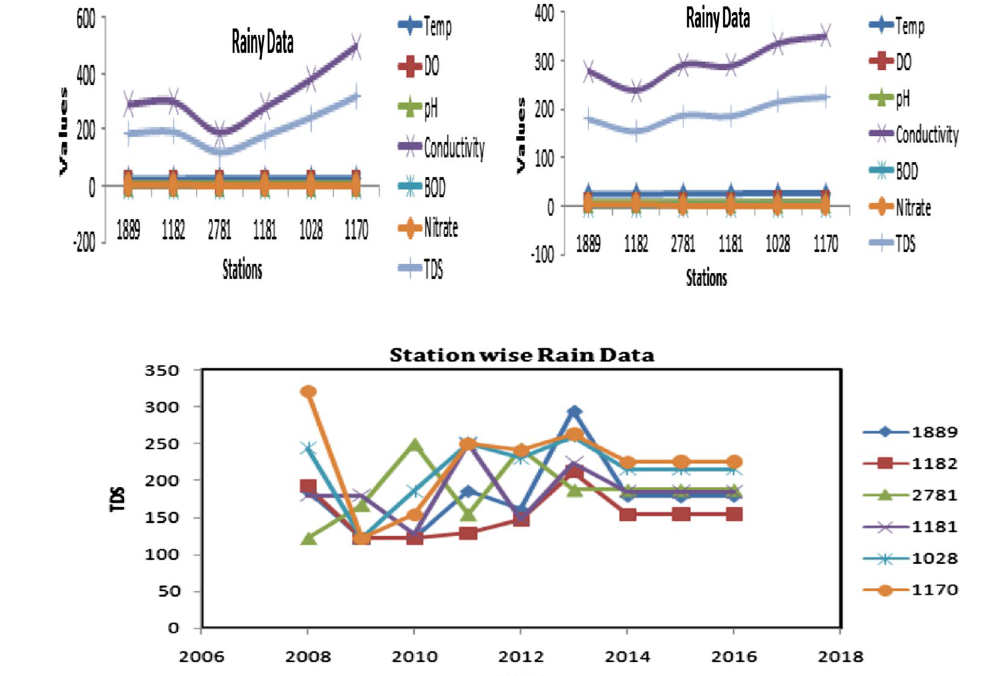
Fig. 7 Yearly variations of dif- ferent water parameters in rainy season for year 2008 and 2016